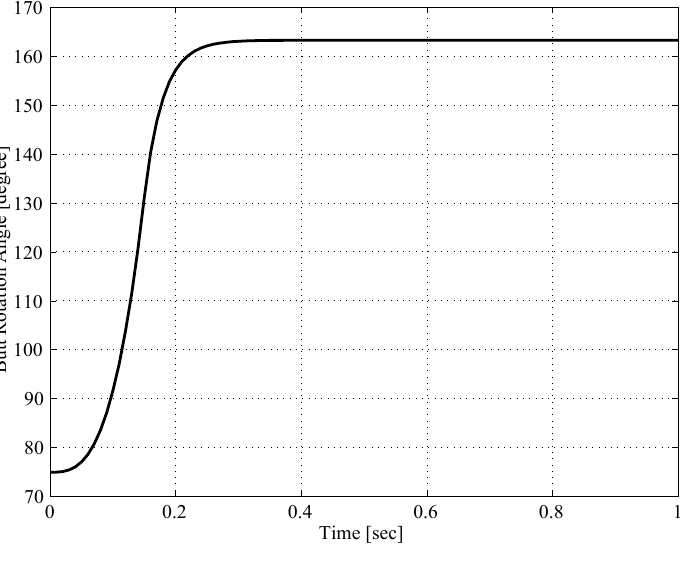
Fig. 8. Fly rod butt end motions in a cast.